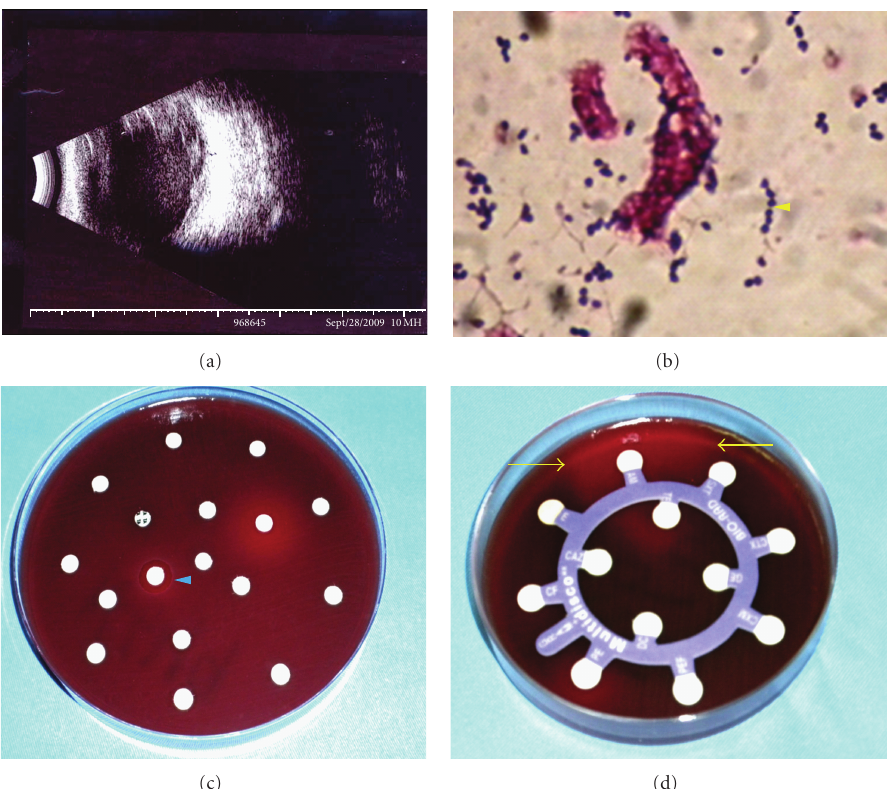
Figure 1: (a): Patient’s B-mode ultrasonography, which shows areas of increased echogenicity in the vitreous cavity. (b) Vitreous cavity sample gram stain that shows gran-positive cocci. ((c) and (d)) Antibiotic sensitivity tests. Blue arrow head: mild bacterial growth inhibition secondary to moxifloxacin disc. Yellow arrows: complete bacterial growth inhibition due to ampicillin sodium